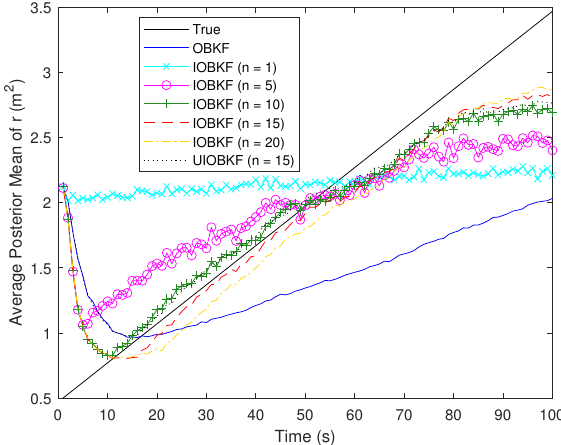
Figure 13. Estimation of noise parameter r